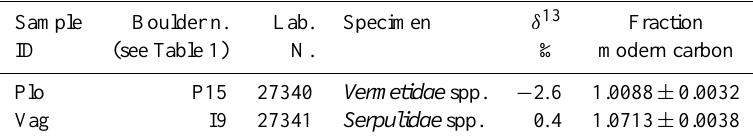
Table 2. AMS 14 C dating results. Both samples yielded modern age. Sample Boulder